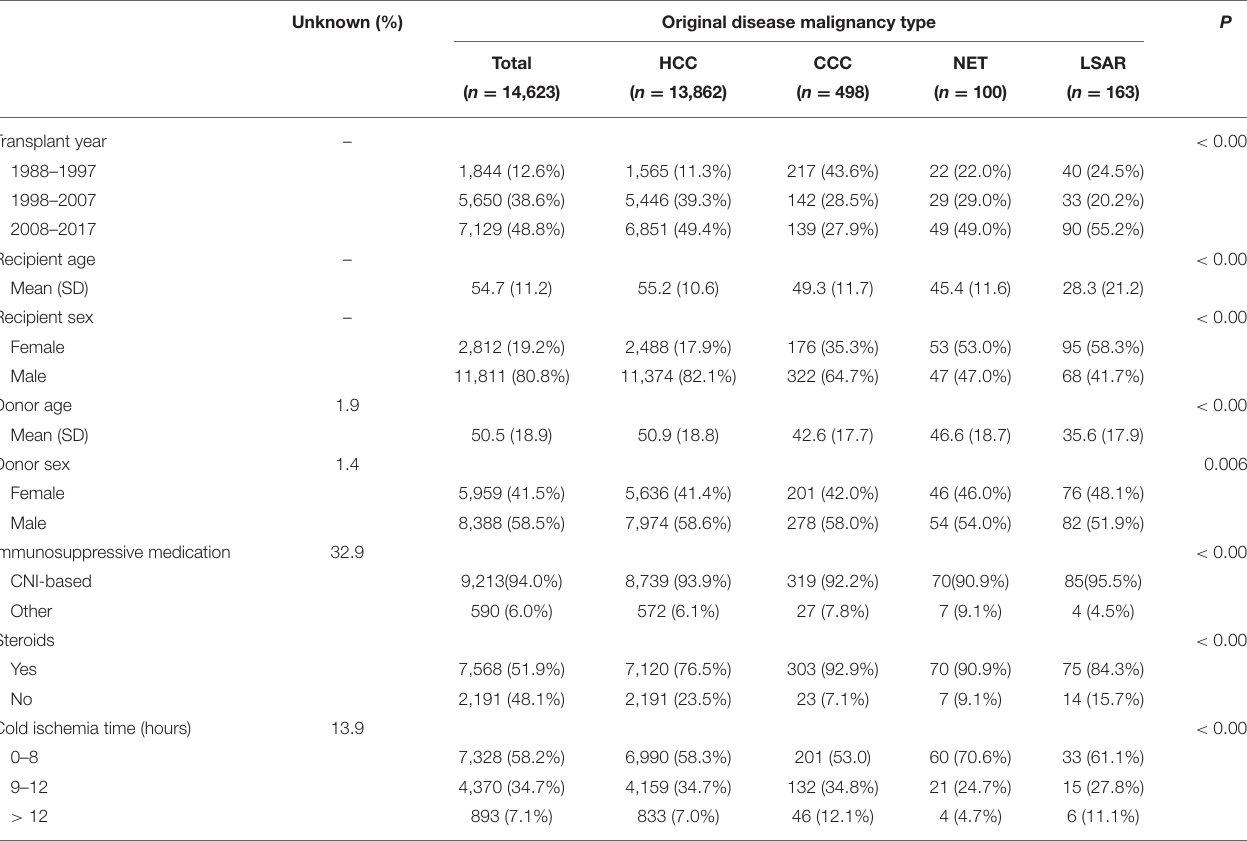
TABLE 1 | Demographics of the study population. Unknown (%) Original disease malignancy